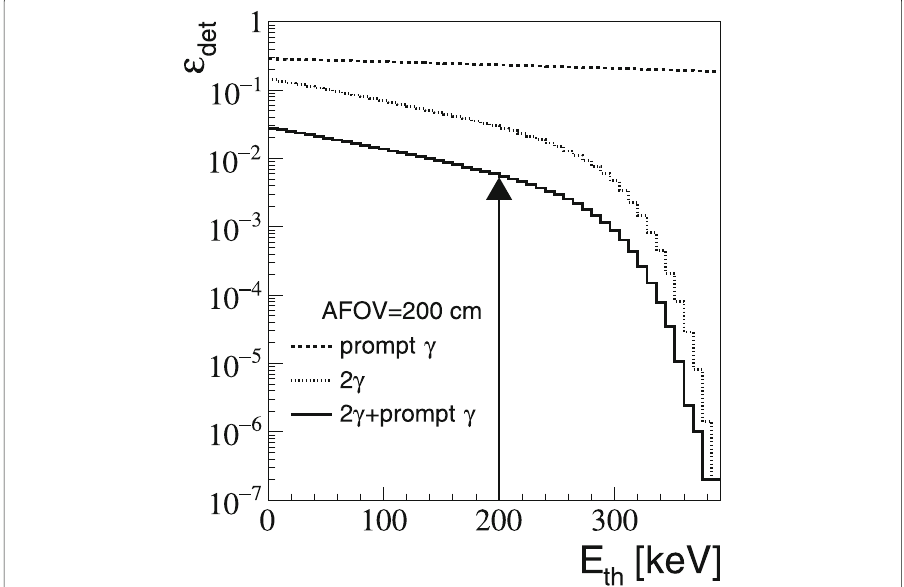
Fig. 4 Registration efficiency (taking into account the geometrical acceptance, probability of gamma quanta registration in the plastic scintillator and J-PET resolution) as a function of applied threshold for the cases of prompt gamma (dashed line), two back-to-back 511 keV photons (dotted line), and two photons simultaneously with the prompt gamma with energy loss higher than 400 keV (solid